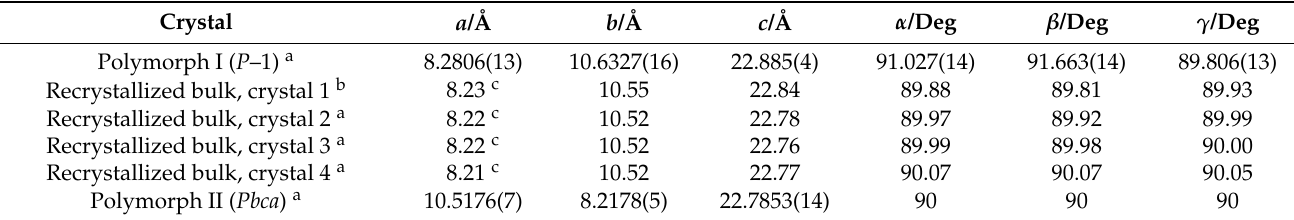
The geometric center of polymorph II of 1 lies on a crystallographic inversion center Table 2. Cell parameters for polymorphs I and II of 1 , and for four crystals selected from the recrystallization of the bulk (Wyckoff site 4b) (Figure 8a). The conformation of the molecule and the bond lengths and sample. angles (caption to Figure 8a) are essentially the same as those in polymorph I (Table 1).